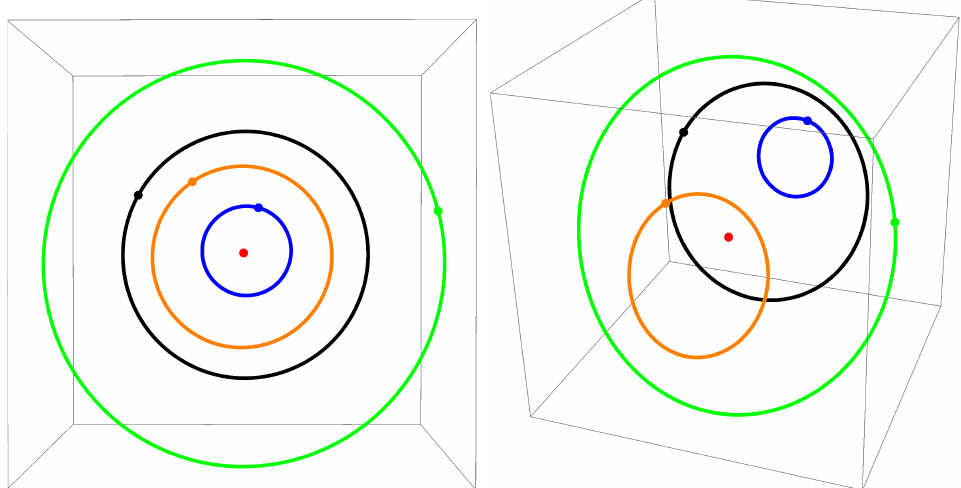
Figure 2. Orbits of the Poincare map in the space ( α , h 3 , h 4 ) are formed by intersection points of the transversal hyperspace k = 0 with trajectories close to the periodic one (red dot). Different orbits are depicted in different colors. Starting points are indicated for each